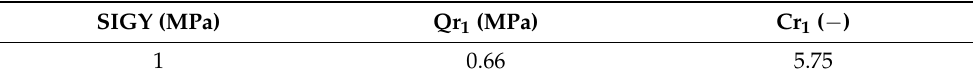
Table 5. Voce’s parameters found from the simulation with Hill’s parameters directly identified from experimental data (as shown in Table